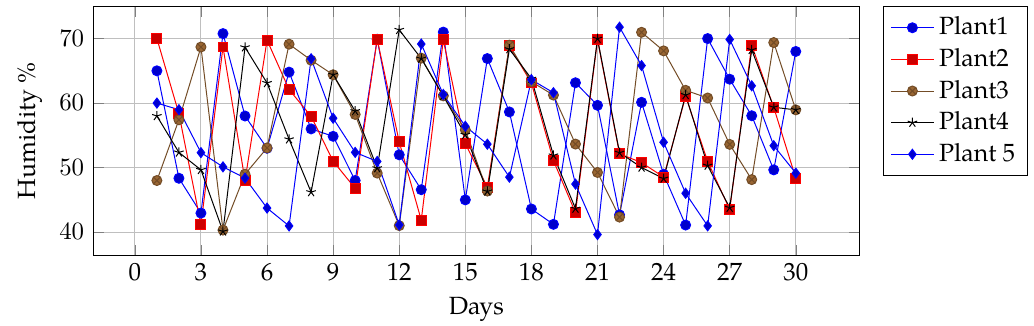
Figure 7: Humidity measured in plants irrigated with the system